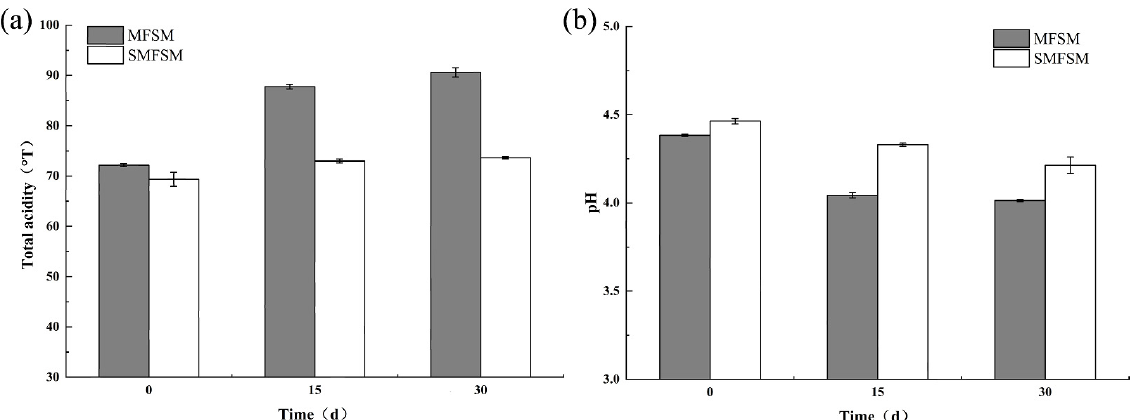
Figure 1. Effects of two mixed fermentation methods on the acidity and pH of samples during storage: ( a ) the change in acidity during storage and ( b ) the change in pH during storage.